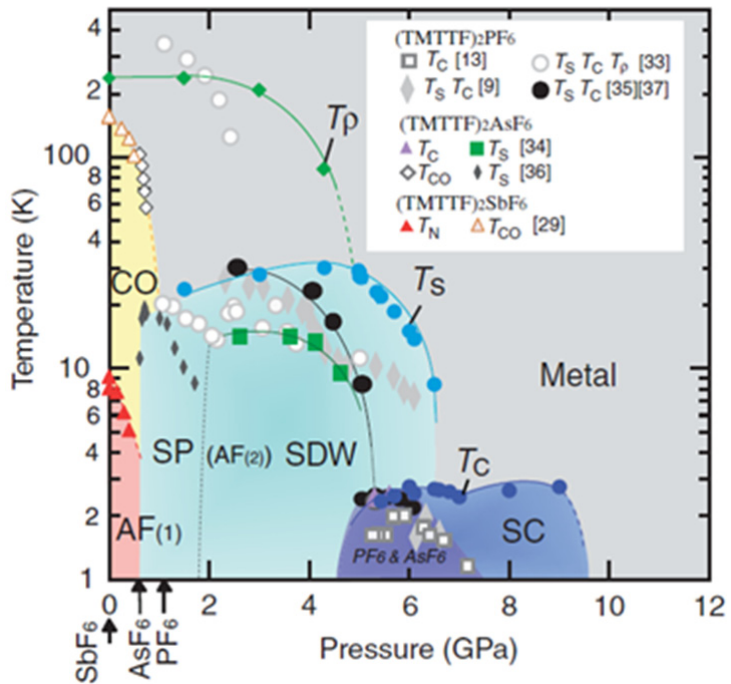
X showing that it is Figure 3. Temperature-Pressure phase diagram of (TMTTF) 2 connected to that of the (TMTSF) X salts. Note that the superconducting T is well above 2 c 2 K and spreading to a wide pressure region and the insulating phase varies from charge order to magnetic state [10]. This is the real system ,which can be compared with Jerome’s generic phase diagram [46]. Reproduced with permission from